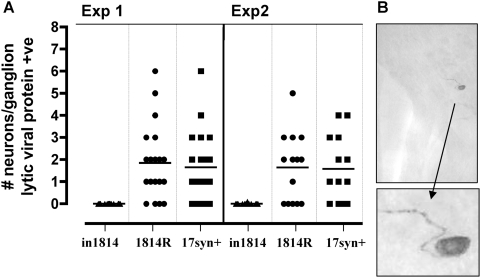
In1814 does not exit latency in vivo.(A) Mice latently infected with the indicated strains were subjected to
HS, and whole TG were assayed for viral protein positive cells 22 hrs
post stress. Each point in the scattergram represents the number of
viral protein positive neurons detected in an individual TG. The
horizontal bars are drawn at the mean. (B) A photomicrograph of a whole
mounted ganglion processed for the detection of HSV-1 proteins 22 hr
post HS shows a single neuron in which the latent genome has entered the
lytic cycle. The brown precipitate evident in the cell body and axonal
tract indicates the presence of viral proteins.